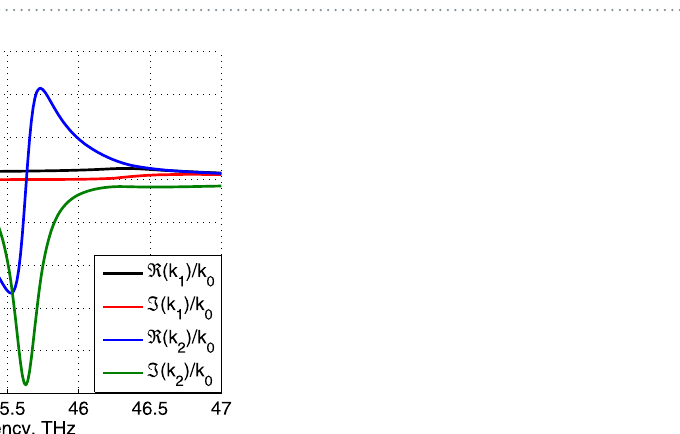
Figure 2. Real and imaginary parts of k 1 and k 2 , normalized to the wavenumber in vacuum k 0 , versus frequency in the vicinity of the  - resonance.